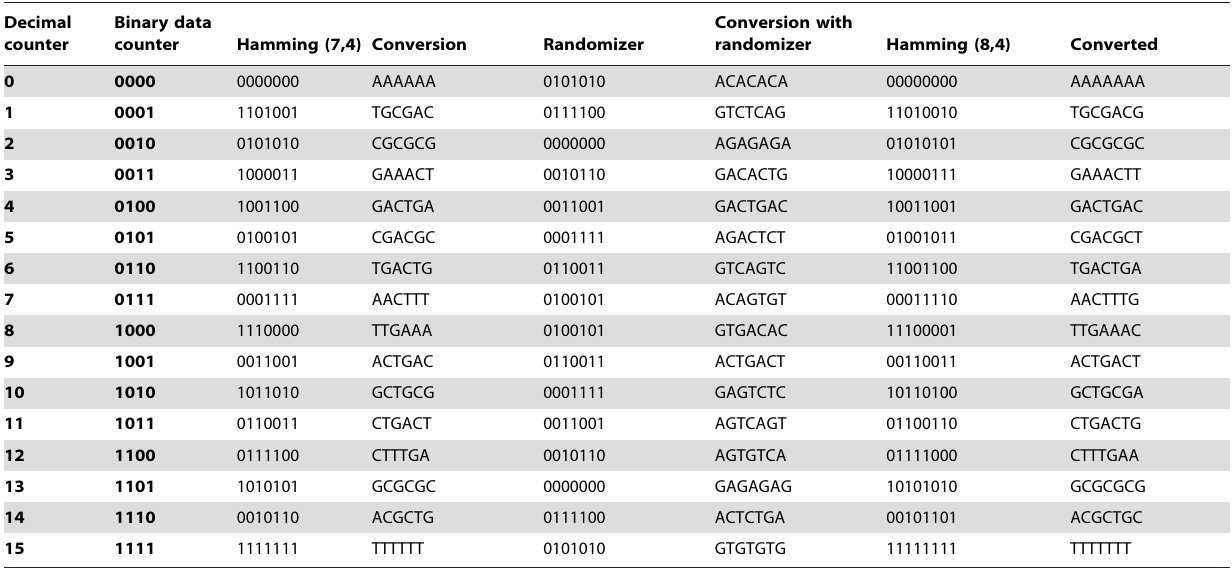
Table 2. Hamming(7,4) codes read with overlap or randomizer.